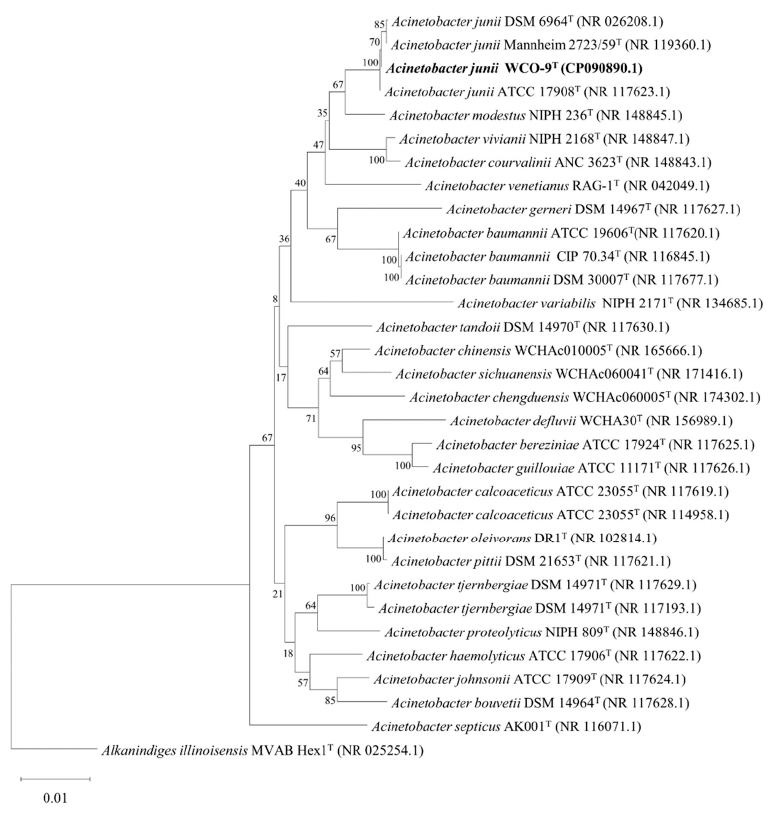
Figure 2. Phylogenetic tree based on 16S rDNA sequences reconstructed using the neighbor-joining method and using the outgroup strain Alkanindiges illinoisensis MVAB Hex1 as a tree root. This tree shows the phylogenetic relationship between strain WCO-9 and closely related species. Bootstrap percentages are based on 1000 replications. Bar: 0.01 substitutions per nucleotide position.